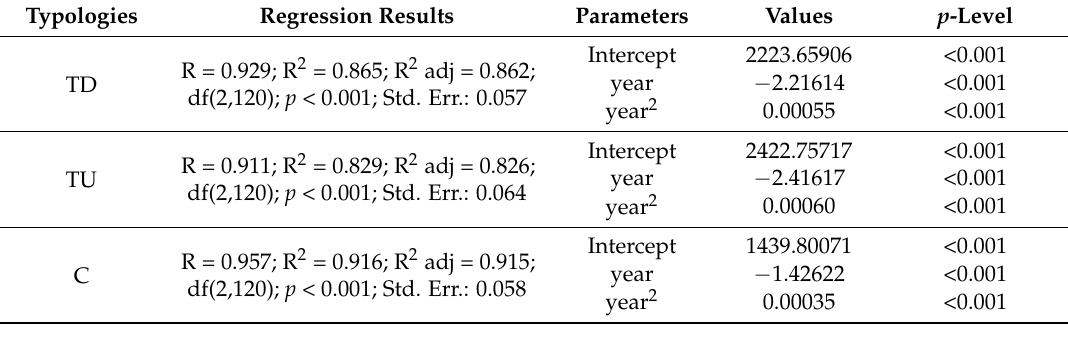
Table 8. Non-linear regression analysis among ring width (dependent variable) and year (independent variable), for damaged (TD) and undamaged (TU) trees and the trees from the control area (C).